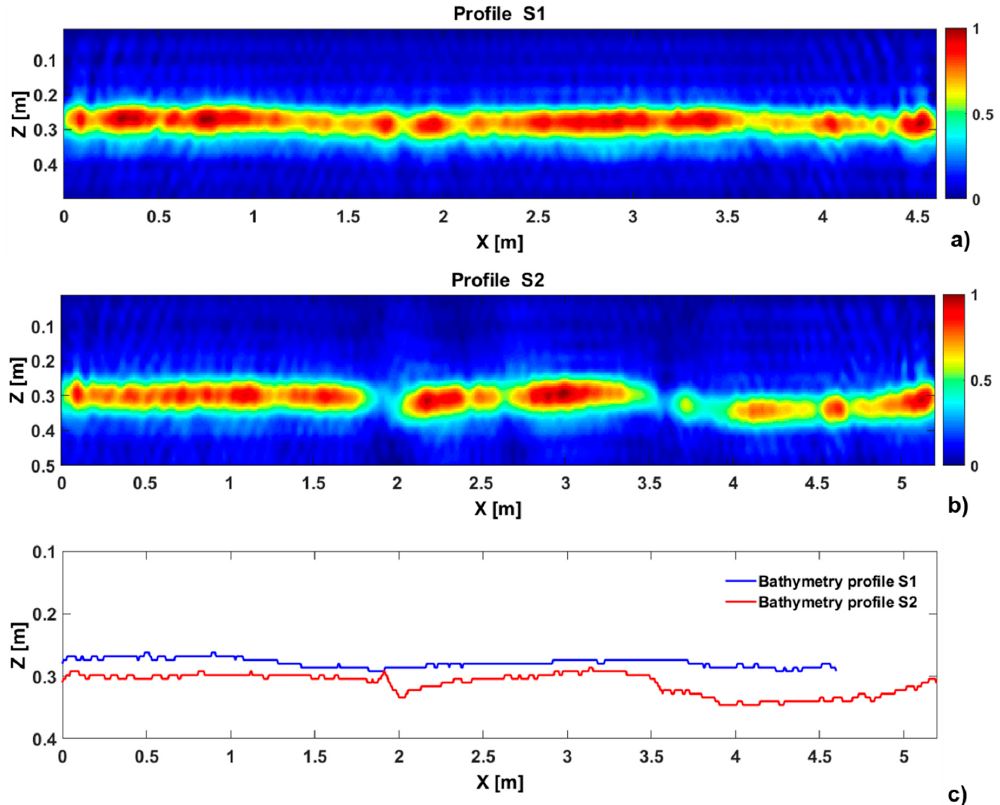
Figure 8. Tomographic images of the freshwater-wet sand interface related to profile S1 ( a ) and S2 ( b ); bathymetry reconstruction related to profile S1 (blue line) and S2 (red lines) ( c ). The tomographic images show the normalized intensity of the retrieved contrast. Remote Sens. 2018 , 10 , x FOR PEER REVIEW